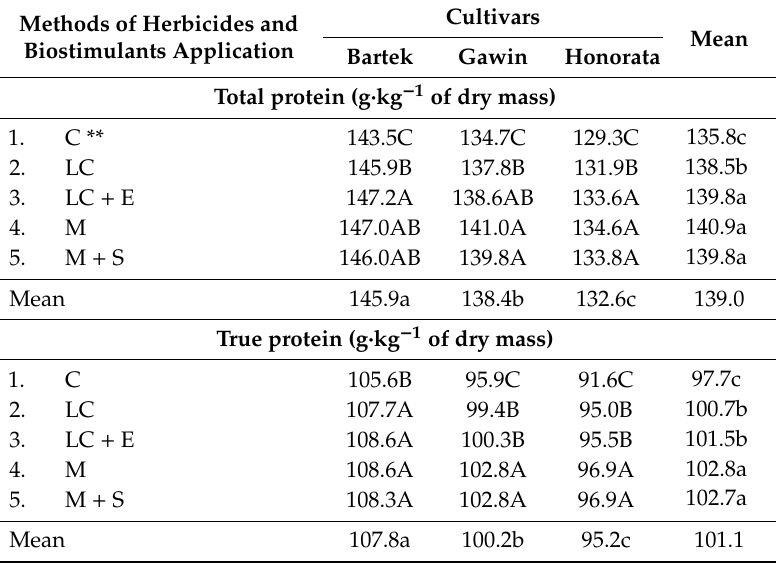
Table 5. Total and true protein content in tubers of potato depending on the treatments of herbicides and biostimulants, application and cultivars of dry